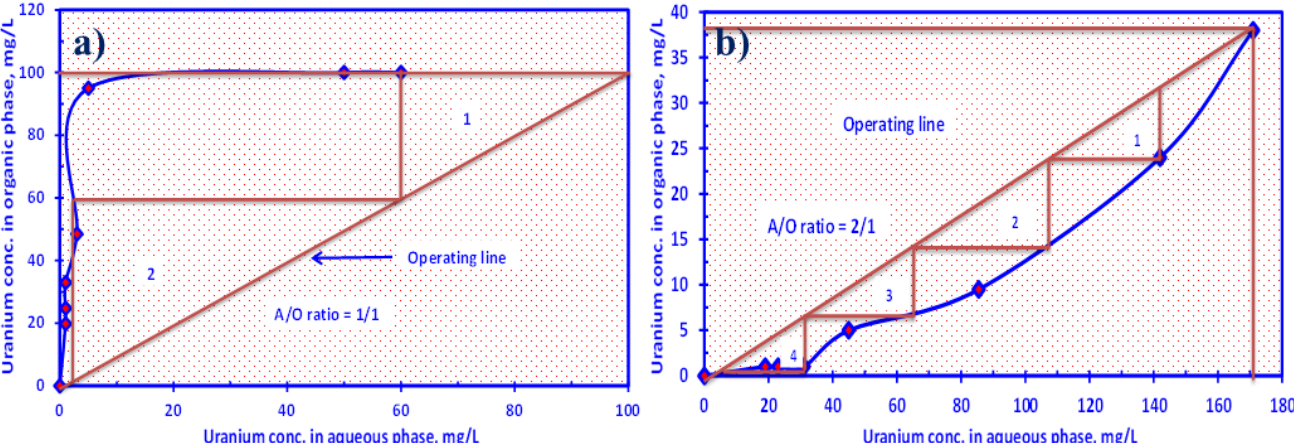
Figure 10. McCabe − Thiele diagram of ( a ) U(VI) ion extraction by HTIP chelating ligand; ( b ) U(VI) ion stripping isotherm from HTIP ‒ U(VI) complex. (U(VI) conc.: 0.42 × 10 − 4 mol/L, HTIP/CHCl 3 conc.: 0.99 × 10 –3 mol/L (10 mg/25 mL), pH 3.0, time: 30 min, T: 25 °C).